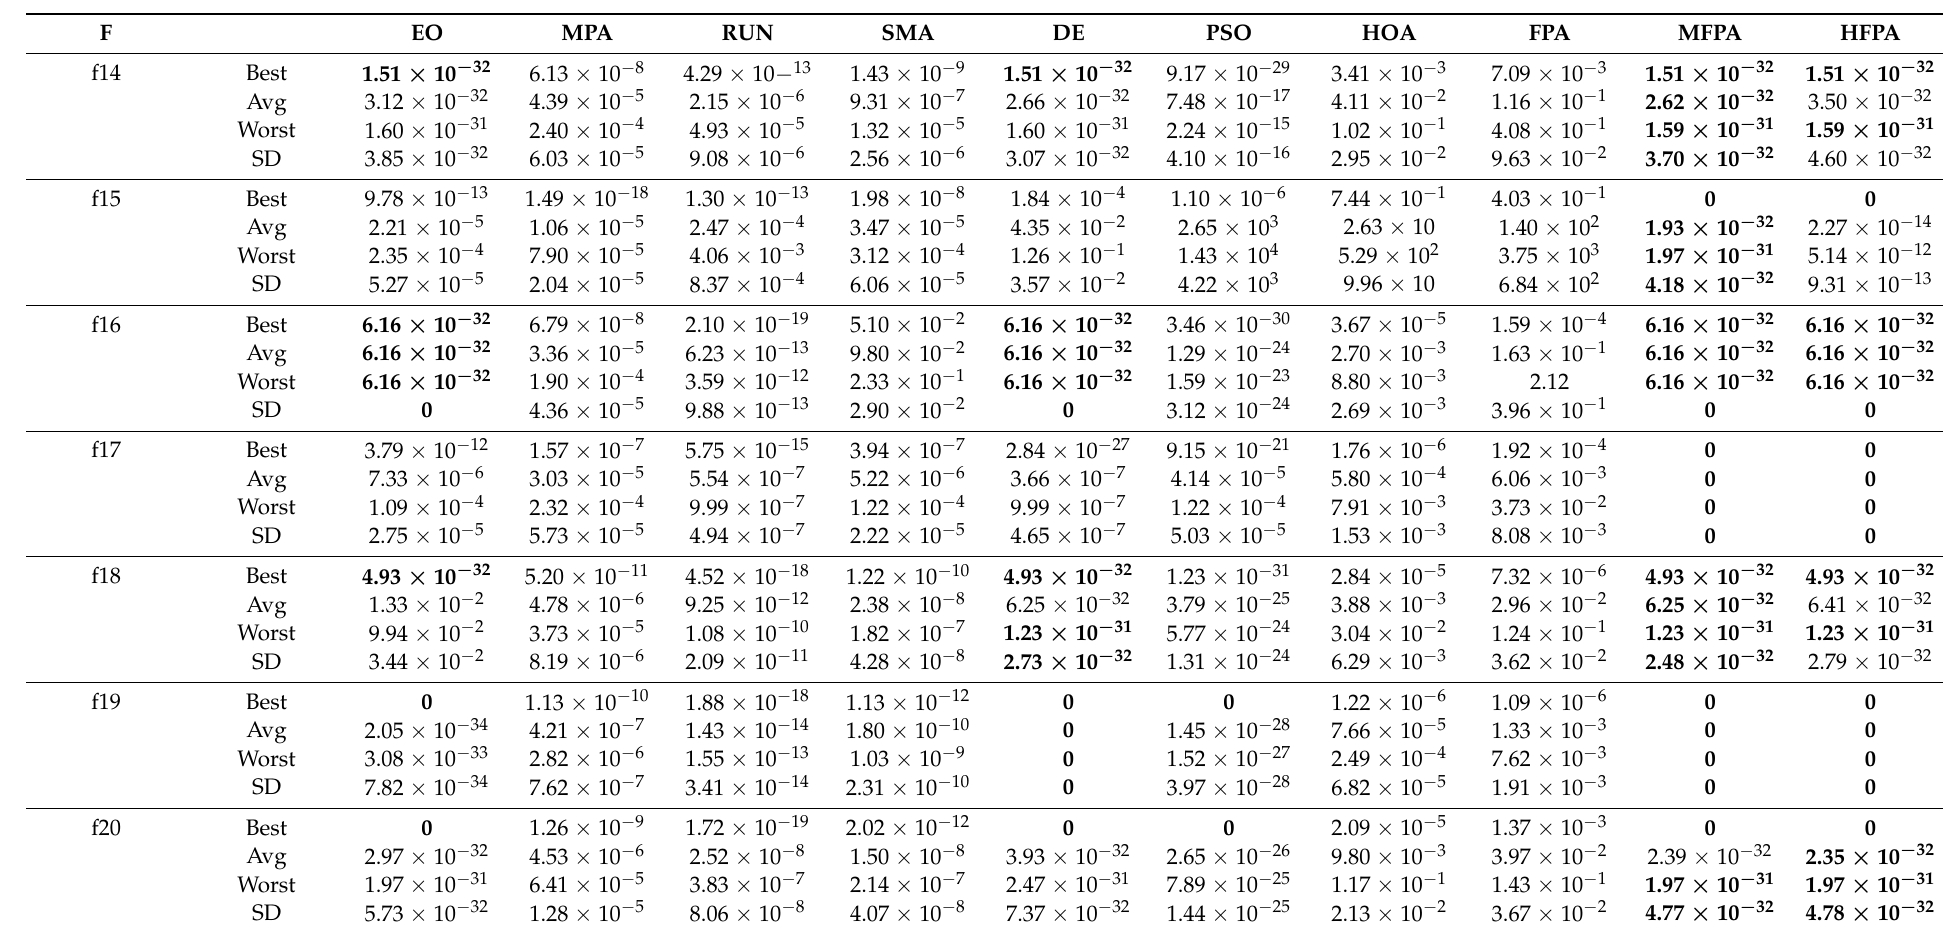
Table 6. Comparison on test cases